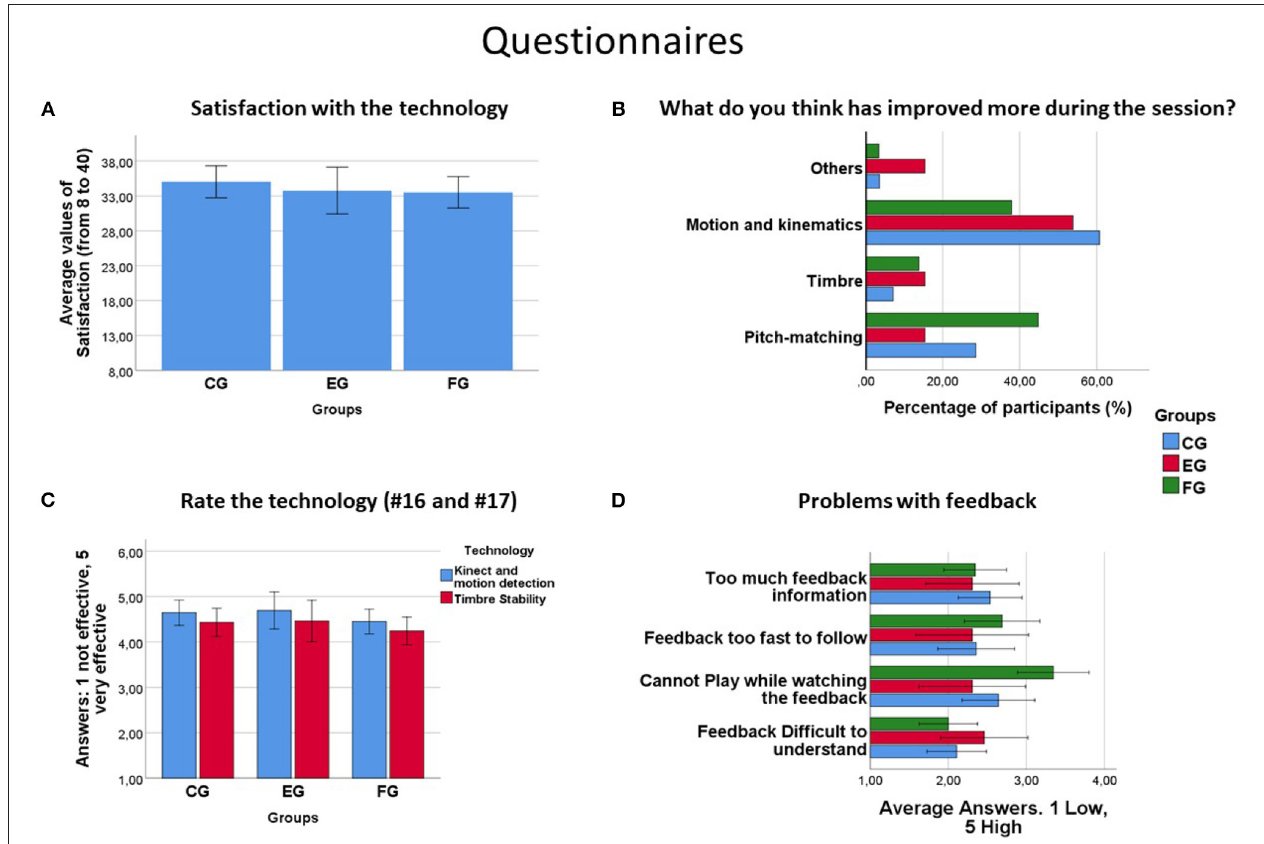
FIGURE 6 | (A) Satisfaction with the technology. No significant differences were found and the average values were similar for the three groups. (B) Answers regarding the perception of the participant’s own performance separated by groups. Just a very small percentage of participants of each group considered that timber stability was the feature that improved more during the session. (C) Rate the technology. Effectiveness of each technology according to participants. Both technologies tended to be highly valued by the participants. However, motion capture feedback tended to be slightly more valued. Also, experts tended to rate the effectiveness of each technology better than beginners. (D) Problems with feedback. Unlike some participants from the FG and CG, experts did not seem to have problems with feedback. More than half of the participants from the FG especially agreed with the fact that it was hard for them to play while watching the feedback (statement